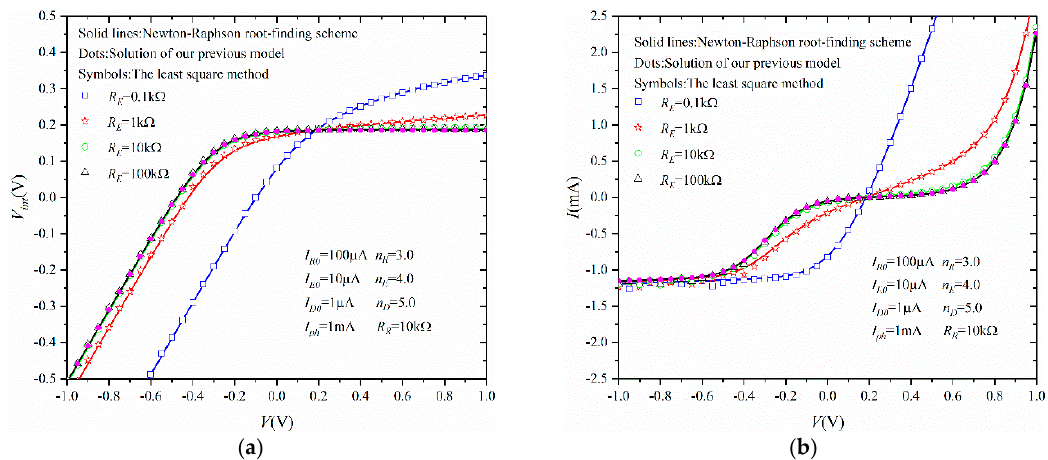
Figure 3. ( a ) V int ( V ) and ( b ) I ( V ) of the circuit in Figure 2 for different R E .